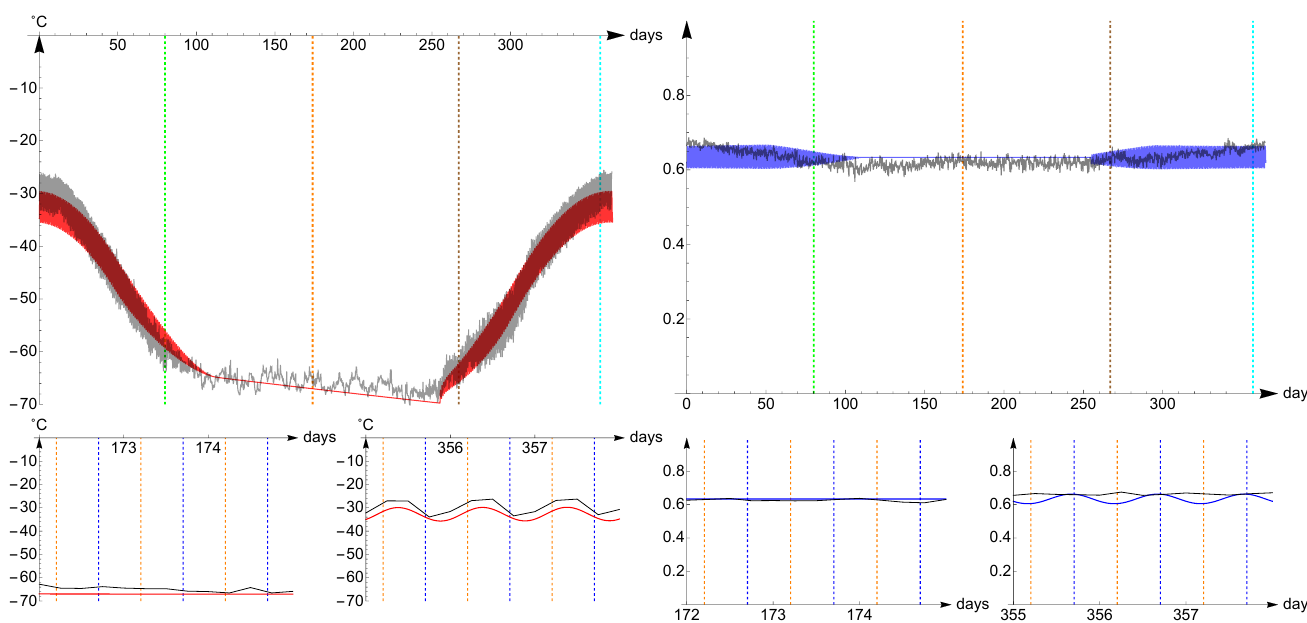
Figure 8. Mean and computed temperature ( left ) and relative humidity ( right ) in Vostok during the year ( top ) and on solstices and equinoxes ( bottom ). In black the average temperatures and humidities, in red simulated temperatures, in blue simulated humidity, the grid lines represent solstices, equinoxes, noons and